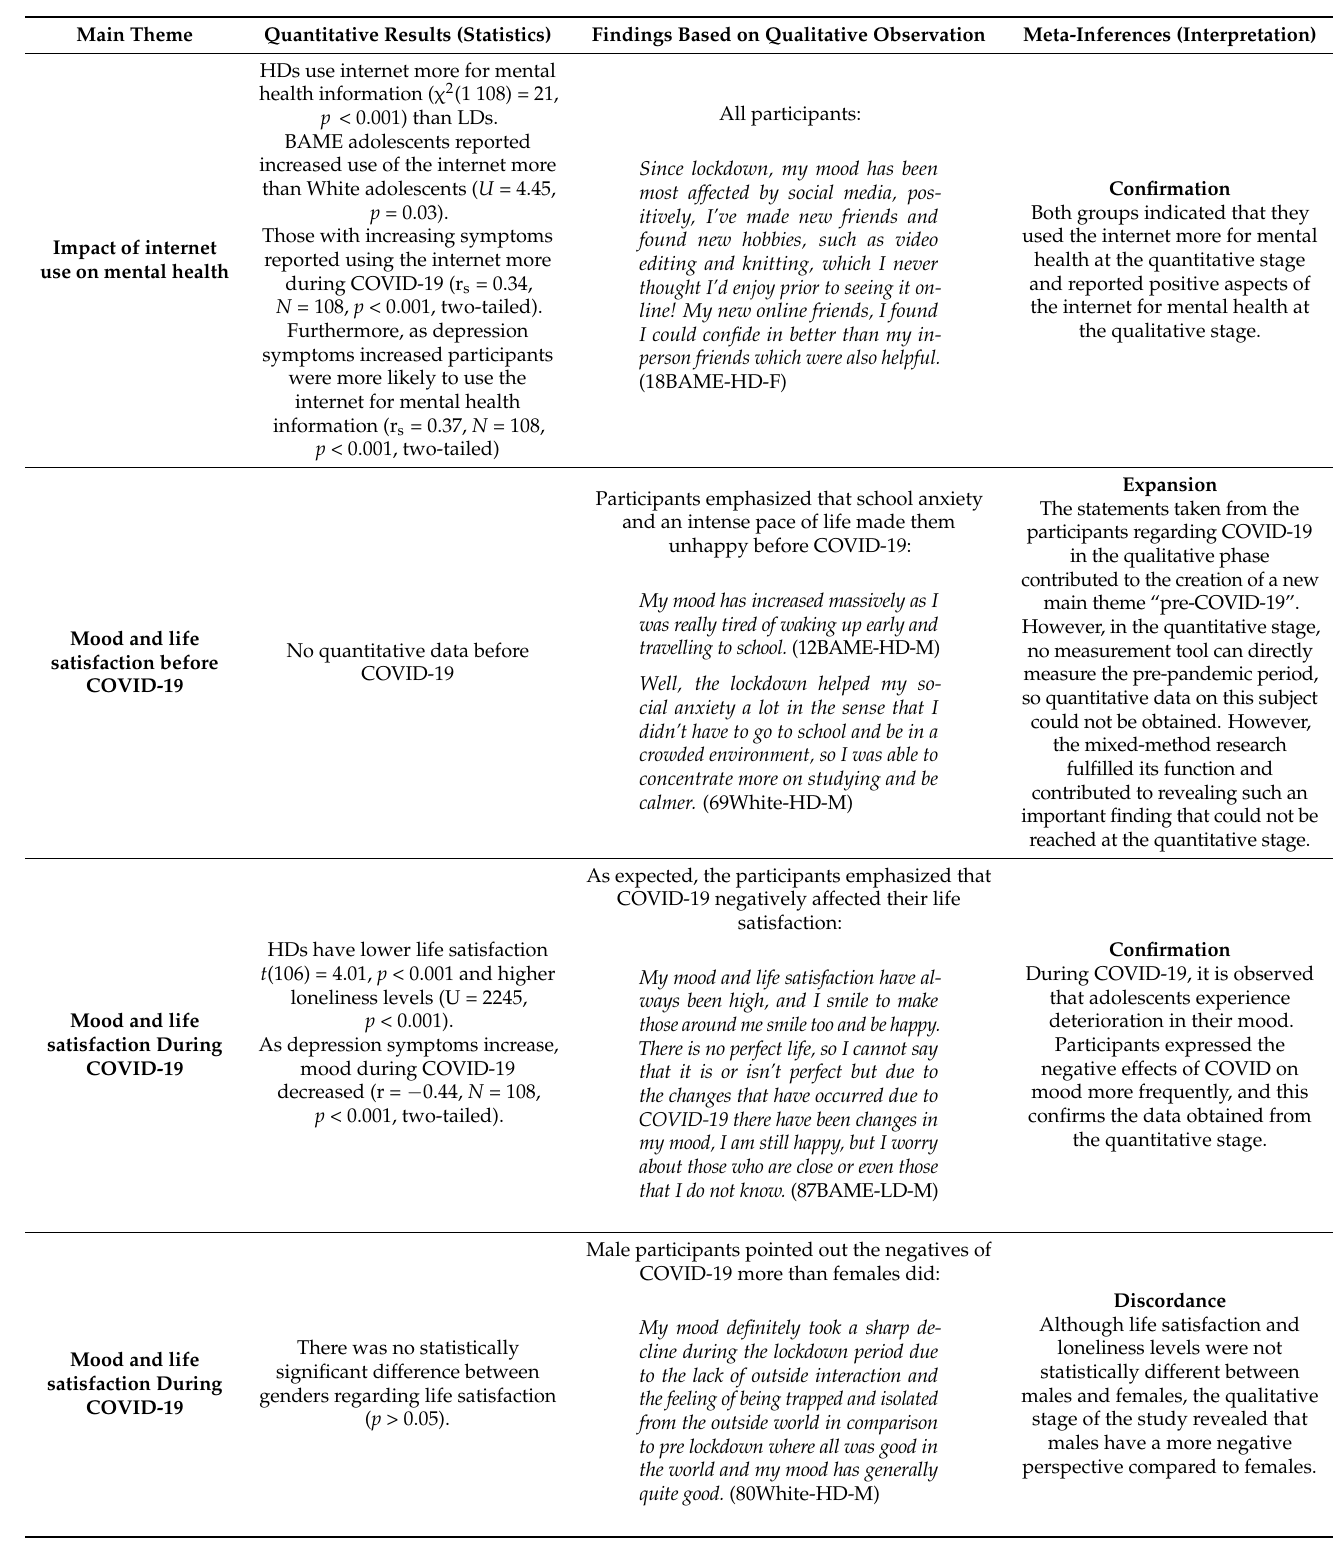
Table 5. Merged analysis of quantitative and qualitative